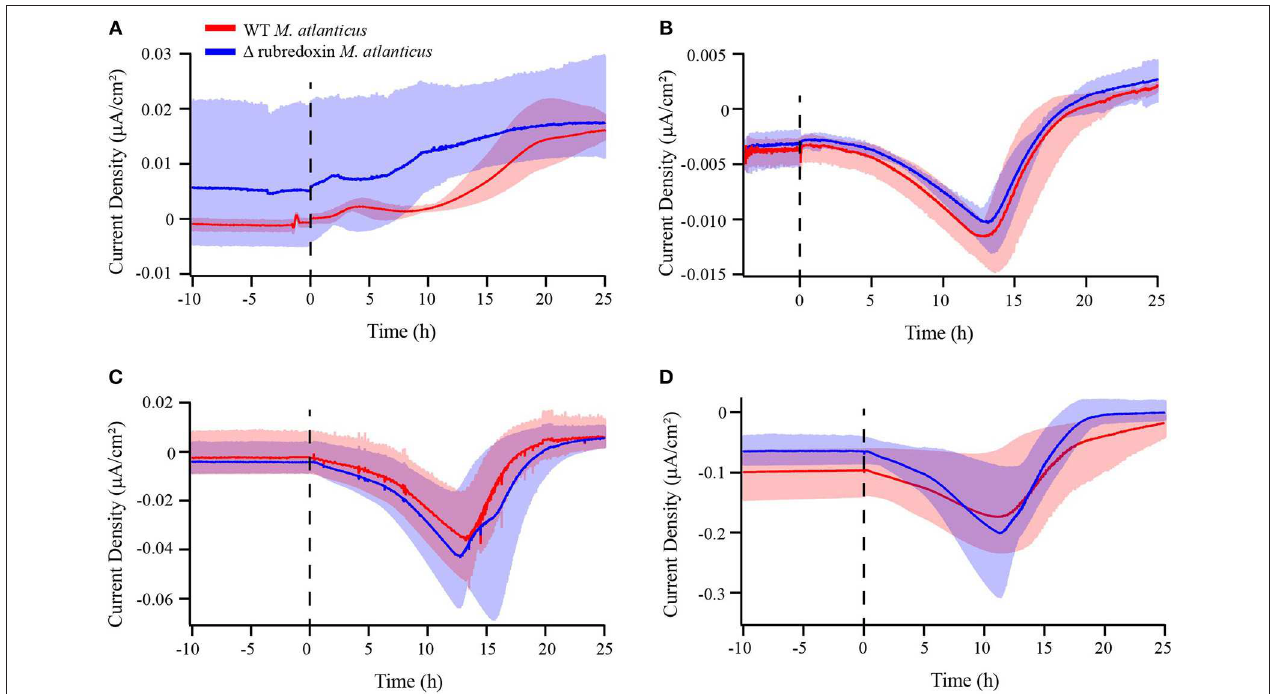
FIGURE 5 | Chronoamperometry of wild type M. atlanticus (red) and rubredoxin deletion ( 1 rub ) (blue) biofilms on carbon cloth working electrodes poised at (A) 510, (B) 310, (C) 260, and (D) 160mV vs. SHE. The dashed line indicates the time of inoculation. Solid lines represent an average of triplicate measurements and shaded areas represent the maximum and minimum values obtained.